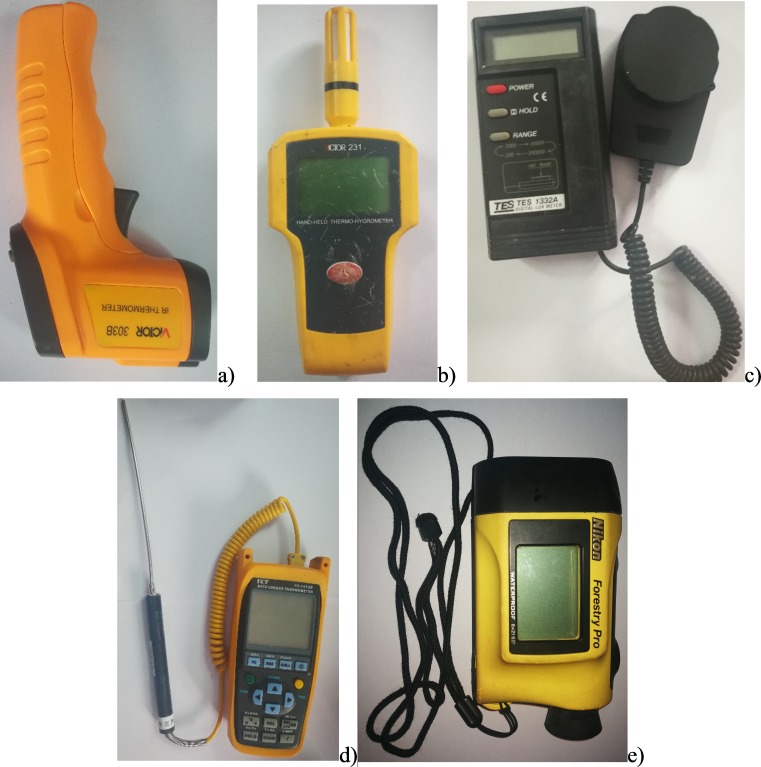
The equipment used in this study.(A) Canopy temperature; (B) air temperature and relative humidity; (C) light intensity; (D) soil temperature; (E) tree height. Pictures by Wenjie Wang.